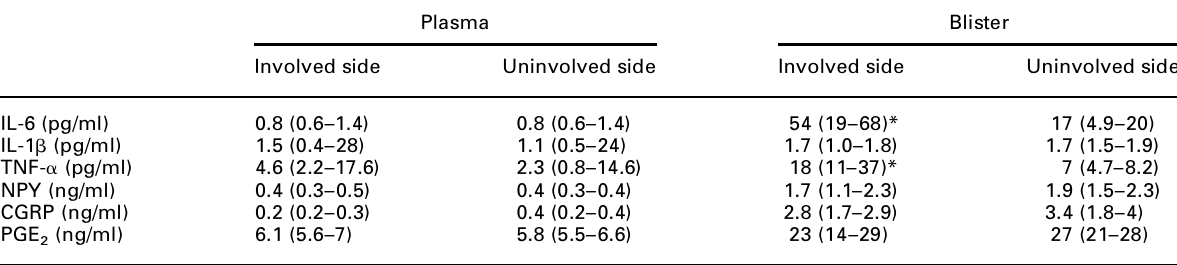
Data are for the nine patients and are presented as median ± interquartile range. IL, Interleukin; TNF- a , tumor necrosis factor- a ; PGE 2 , prostaglandin E 2 . *Wilcoxon rank sum test, p <